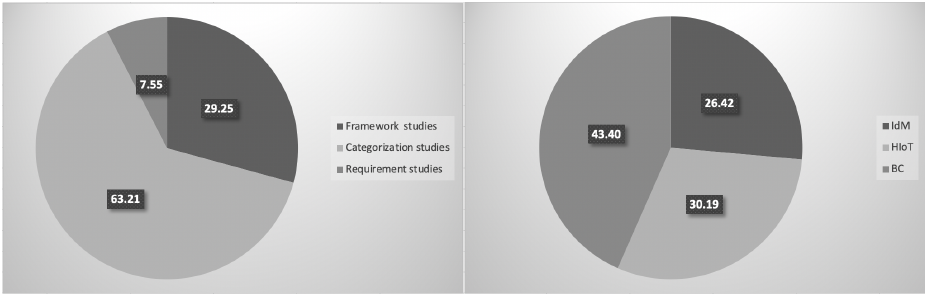
Figure 3. The percentages of the study classifications are based on the covered assets and the main contributions.